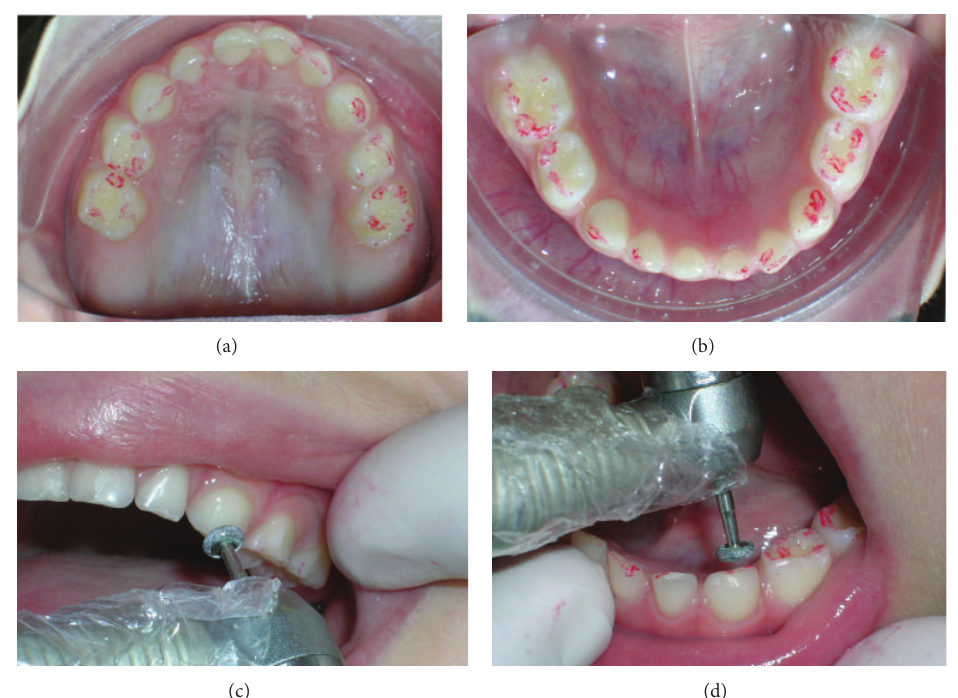
Figure2:Oclusalviewwithcarbonprintandselectivewears.(a)Superioroclusalview,(b)inferioroclusalview,(c)selectivewearsonsuperior teeth, and (d) selective wears o inferior